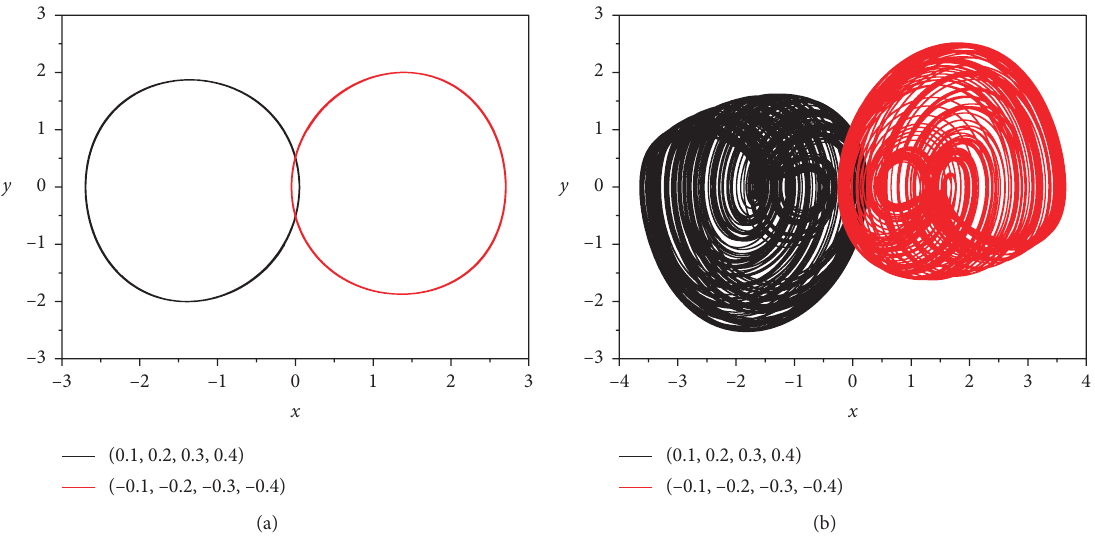
Figure 1: (a) Periodic attractors for ( x , y , z , w ) b � 0.3, and c � 1.4. (b) Chaotic attractors for ( x , y , z , w ) 0 � (0.1, 0.2, 0.3, 0.4), d � 0.8 and ( x , y , z , w ) 0 � ( − 0.1, − 0.2, − 0.3, − 0.4), d � − 0.8, while a � 1.4, b � 0.3, and c � 1.4.